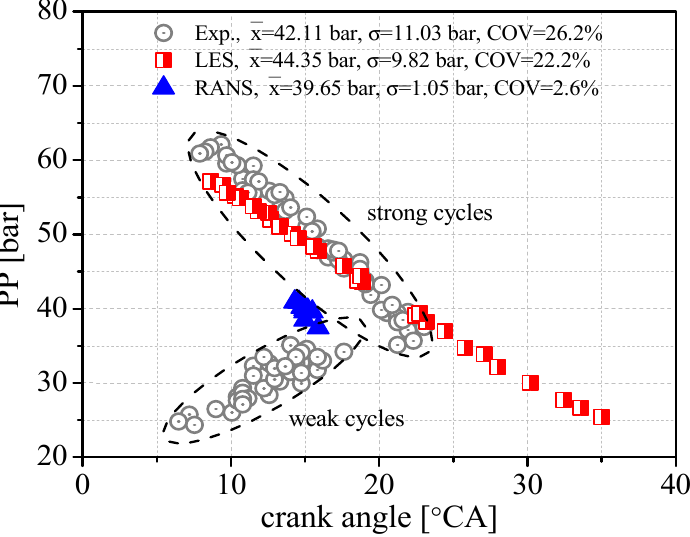
Figure 4. The scatter plot of the in-cylinder peak pressure (PP) and the corresponding crank angles. The two distinct combustion types can also be observed in Figure 5. The weak combustion cycles with peak pressure rise rate (PPRR) below 2 bar/ ◦ CA are located before TDC, while the strong cycles with PPRR ranging between 1 and 20 bar/ ◦ CA are located after TDC. Although there are noticeable differences between the predicted and measured average PPRR and COV, the LES simulations were able to predict the two distinct combustion types. However, the LES produced fewer number of weak cycles and the corresponding crank angles closer to TDC than the experimental observations. In addition, the LES predicted more retarded crank angles of PPRR for some strong cycles, indicating very the late auto-ignition processes for those cycles in